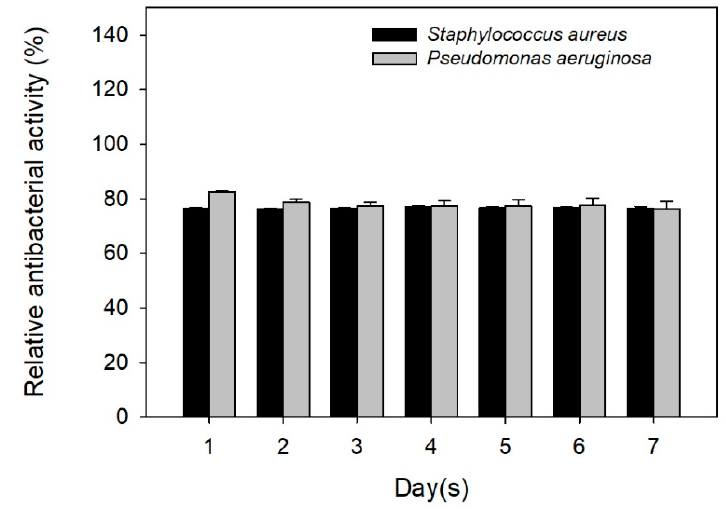
Figure 7. Susceptibility trend of the released tetracycline against Staphylococcus aureus and Pseudomonas aeruginosa .